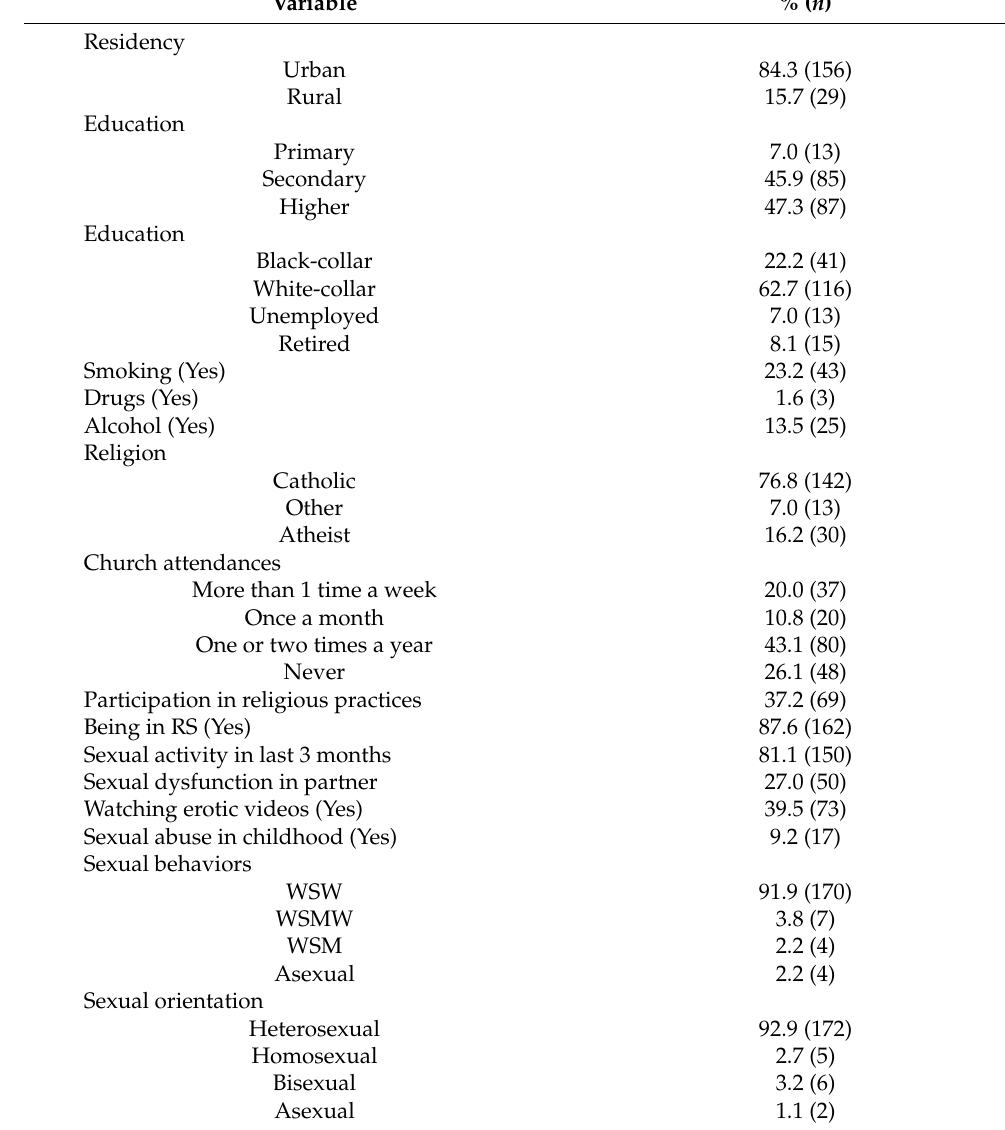
Table 1. General characteristic of the studies population—descriptive statistics. Variable % ( n